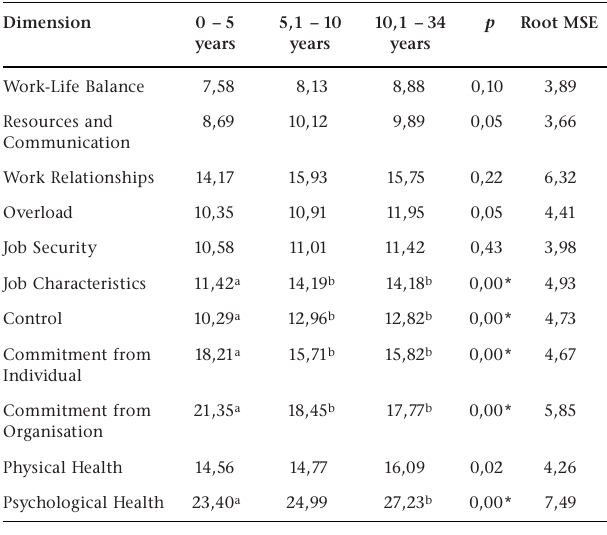
Structural equation modelling was used to test whether occupational stress leads to ill-health and to determine whether organisational commitment moderates the effects of occupational stress on health. The final model is given in Figure 2. Results indicated that the model did fit the data adequately ( (cid:1) 2 = 109,19, GFI = 0,95, AGFI = 0,91, NFI = 0,94, IFI = 0,96, TLI = 0,94, CFI = 0,96 and RMSEA = 0,08). As can be seen in Figure 2, the path from Occupational Stress to Ill-health is significant. This means that high levels of occupational stress as experienced by employees may result in ill-health with either physical or psychological health problems, or both. According to the model, it seems that individual commitment to the organisation moderates the effect of occupational stress on ill- health. It means that the level of ill-health depends not only on the level of occupational stress, but also on the level of individual commitment to the organisation. It is indicated in Figure 1 that 48% of the variance in organisational commitment is explained by occupational stress and 28% of the variance in ill-health is explained by organisational commitment and occupational